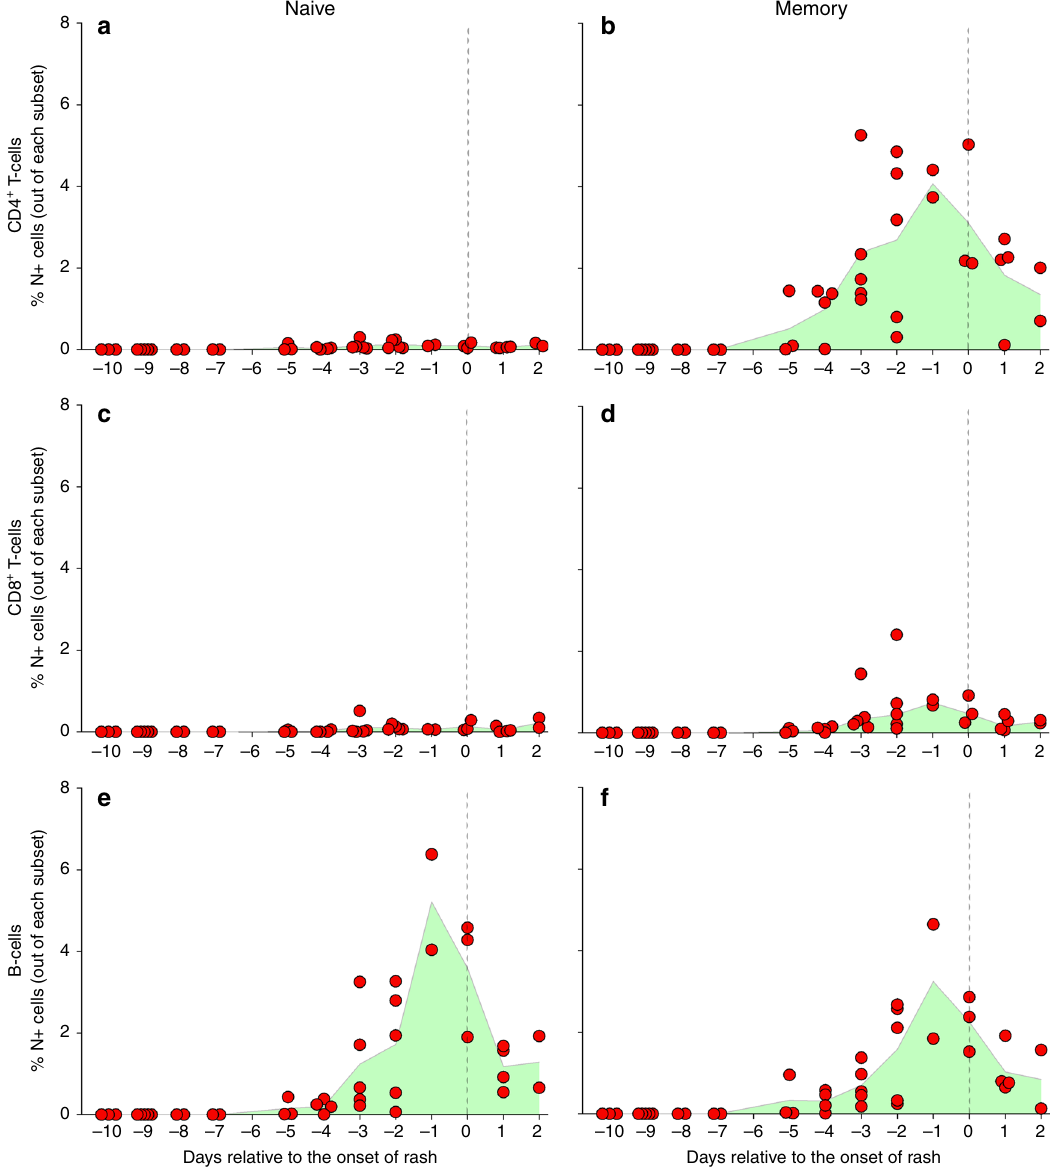
Fig. 3 Frequencies of MV-infected lymphocytes during acute measles. a – f Frequencies of MV-N + cells in naive and memory lymphocyte subsets relative to the onset of rash ( n = 40 donors). Each red dot represents a unique donor, the green shaded area indicates the mean of the samples from each time point, and the vertical dashed line represents the onset of